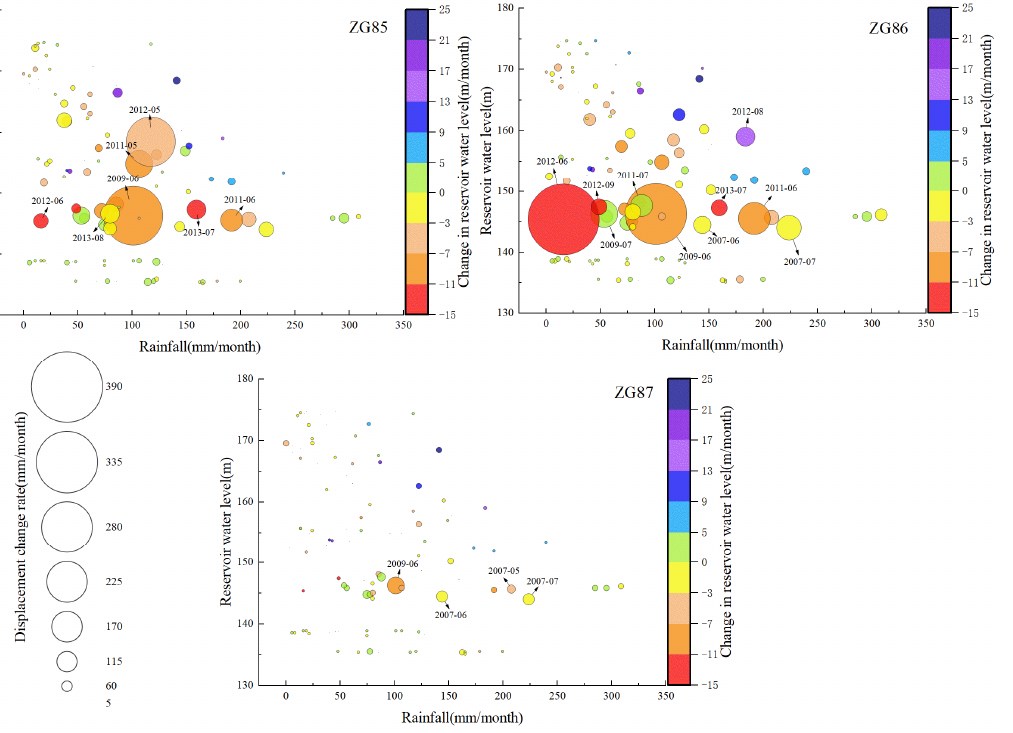
Figure 5. Correlation of monthly displacement change rate at each monitoring station with the RWL, rainfall, and the change in the RWL.